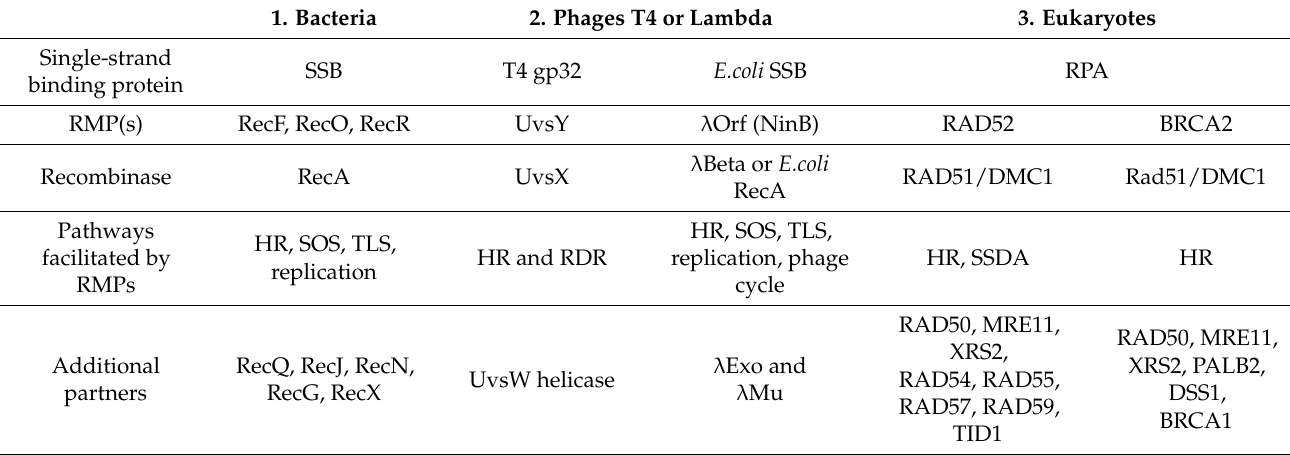
Table 1. Overview of recombination mediators and partners in different organisms. This table lists RMPs, their interaction partners and functions in different